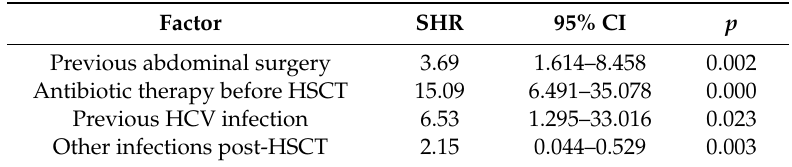
Table 5. Multivariate analysis of risk factors for